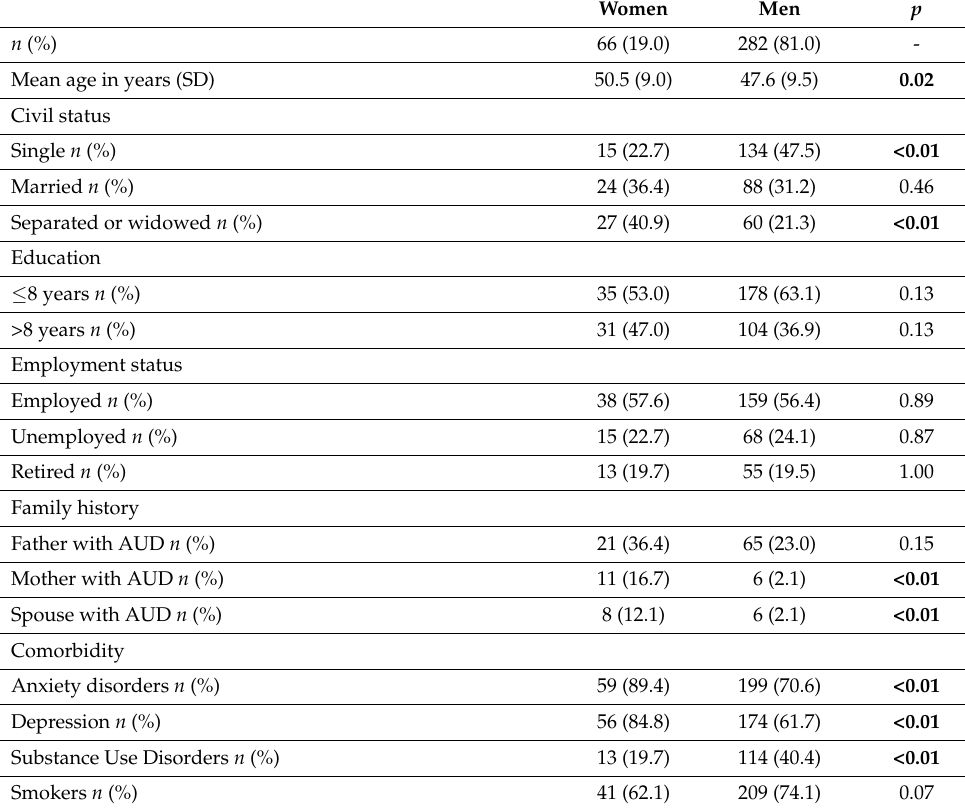
Table 1. Main gender differences and similarities of a sample of Sardinian AUD